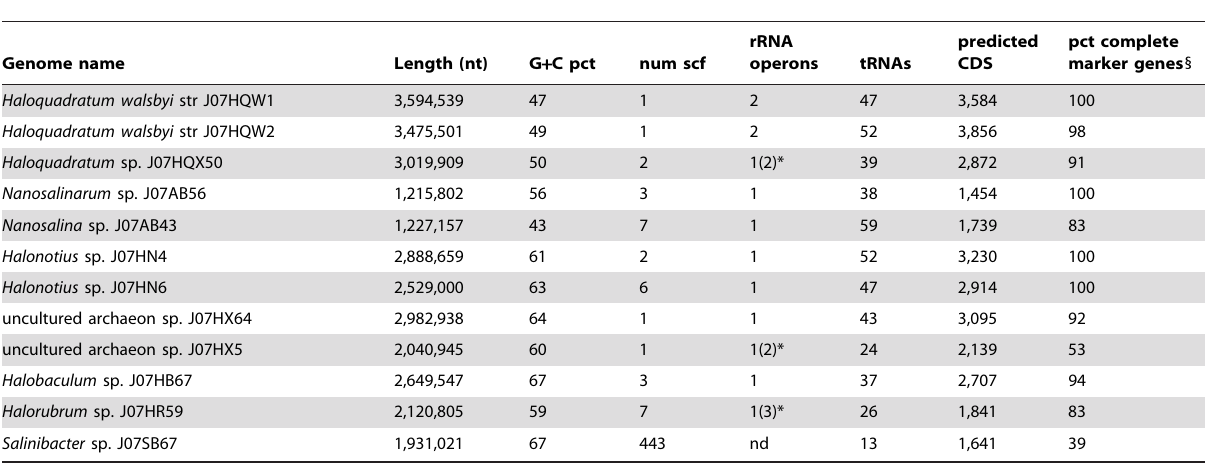
Table 1. Consensus population genome